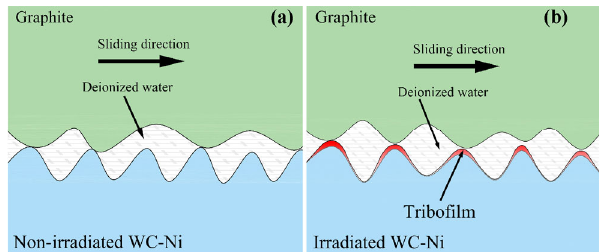
Fig. 12 Friction statures schematics of (a) non-irradiated WC-Ni; (b) irradiated WC-Ni against under deionized